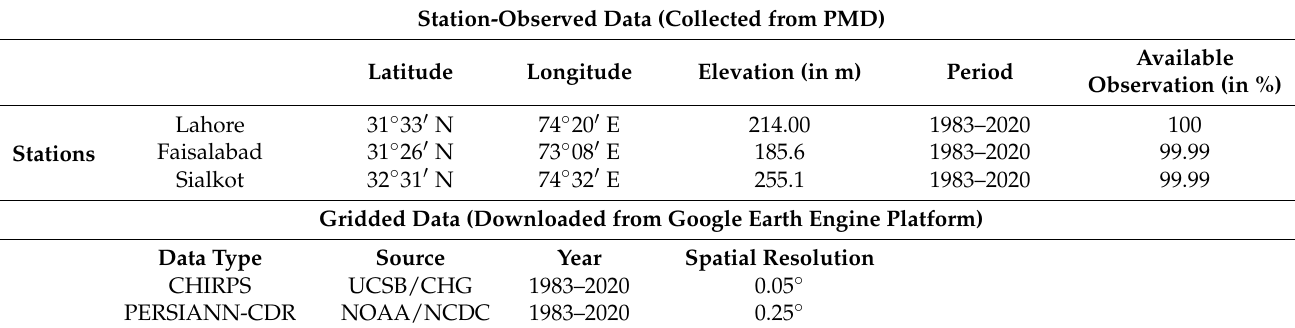
Table 1. Data utilized to examine the rainfall distribution and trends in central Punjab.